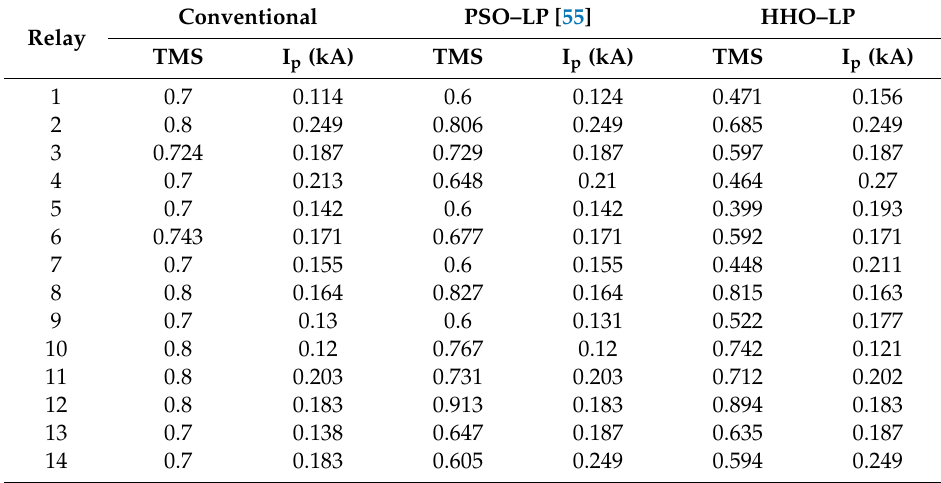
Table 4. Relay settings obtained with particle swarm optimization (PSO)–LP and HHO–LP for IEEE-8 bus system at a wind speed of 10 m / s. TMS, time multiplier setting.